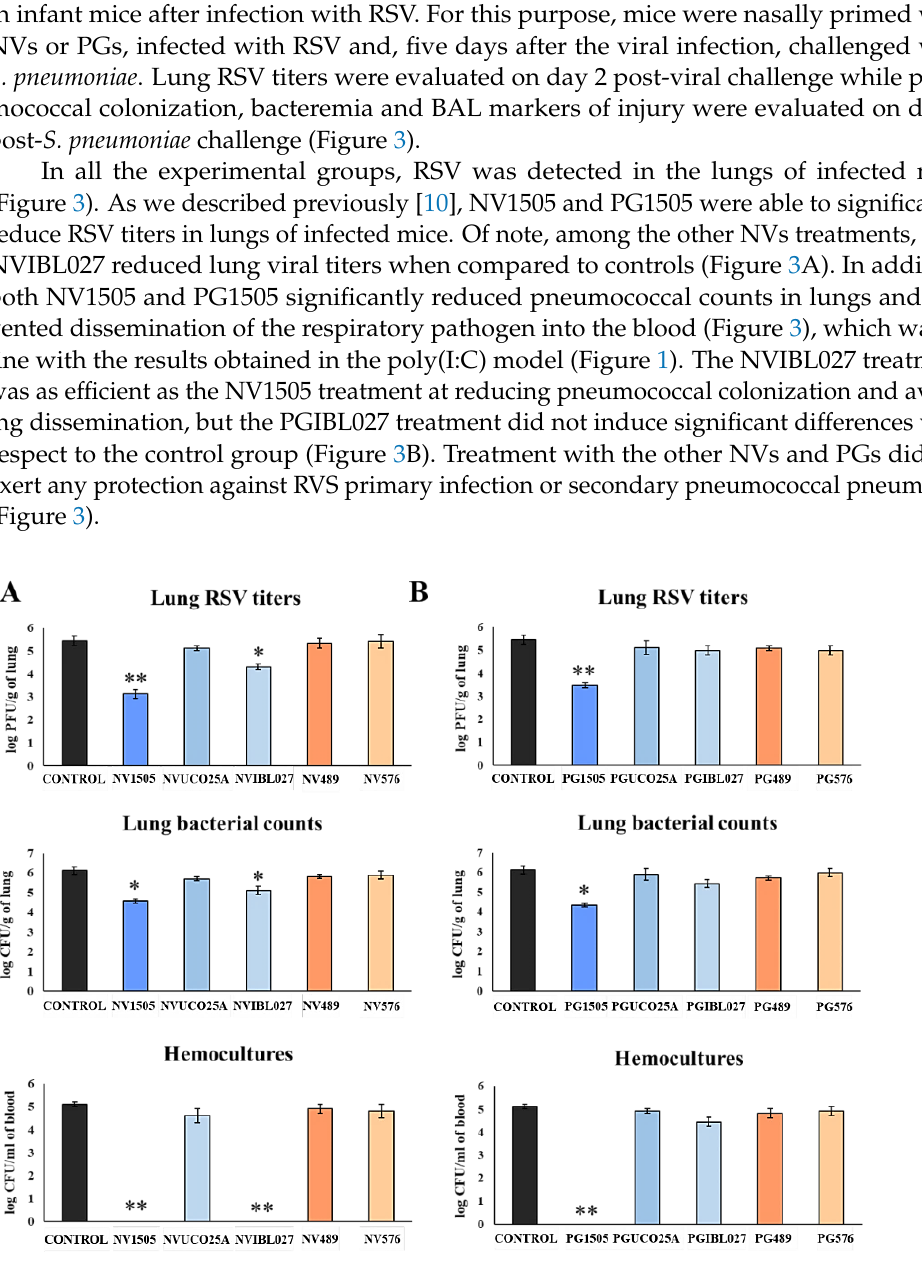
Figure 3. ( A ) Ability of non-viable (NV) L. rhamnosus CRL1505, CRL498, CRL576, UCO25A and IBL027 and ( B ) their peptidoglycans (PGs) to improve the resistance to secondary pneumococcal pneumonia after primary infection with respiratory syncytial virus (RSV). Infant mice were nasally primed with NVs or PGs for two consecutive days, then challenged with RSV on day 3 and finally infected with S. pneumoniae serotype 6B five days after the viral infection. Non-treated infant mice infected with RSV and challenged with S. pneumoniae were used as controls. Lung RSV titers were evaluated on day 2 post-viral challenge while lung bacterial cells counts and hemocultures were determined on day 2 post-pneumococcal challenge. Asterisks indicate significant differences between treated and control groups; * ( p < 0.05) and ** ( p < 0.01).